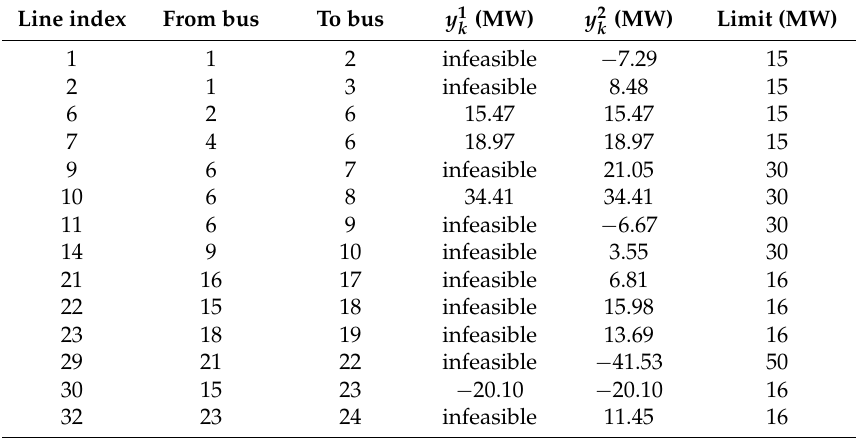
Table 1. Maximum line flows in the feasibility cut acceleration